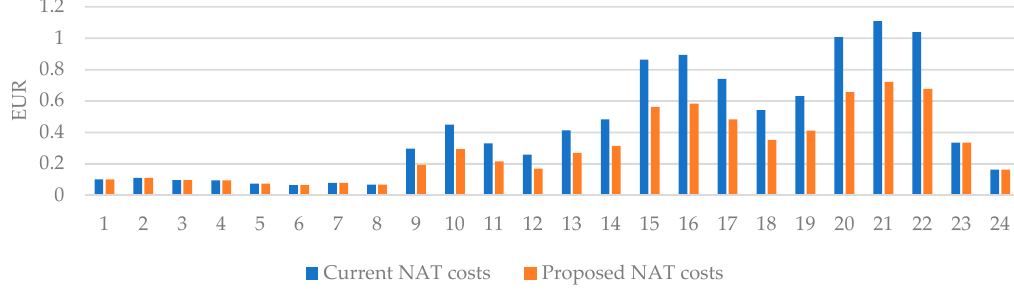
Figure 7. Comparison between the sum of hourly NAT costs for a 2-period Time-of-Use rate in a BaU scenario and in the proposed business model during the 6-month trial period. Source: Authors’ own elaboration.